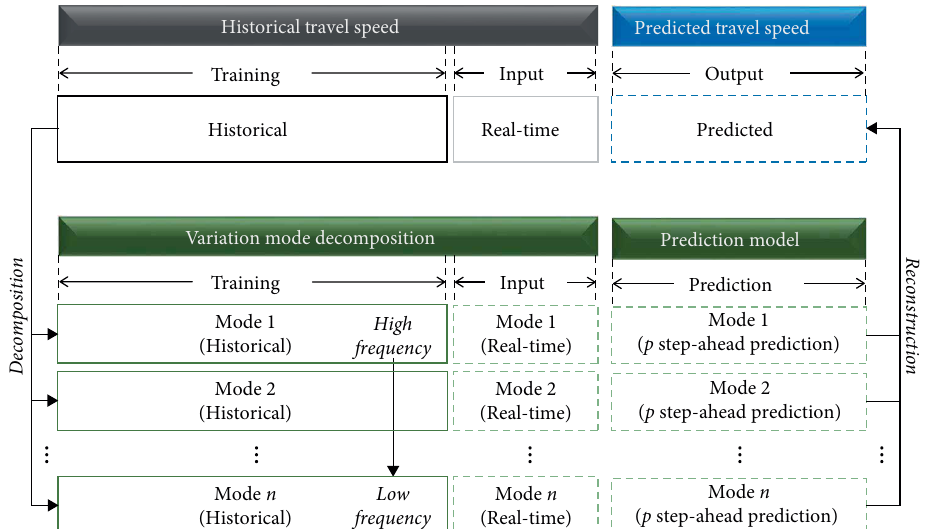
Figure 2: Flow diagram of a hybrid model using variational mode